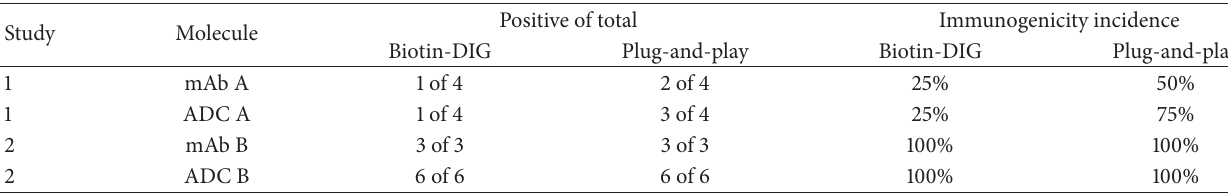
Table 5: Summary of immunogenicity data for cynomolgus monkey Studies 1 and 2 with the biotin-DIG ELISA and the plug-and-play assay. Samples from cynomolgus monkey studies with two ADCs and their corresponding mAbs were analyzed in the plug-and-play assay. The number of animals that developed anti-drug antibodies after exposure to the above molecules and the immunogenicity incidence obtained with this assay were compared to those previously obtained in the biotherapeutic-specific biotin-DIG ELISA. In Study 1, the plug-and-play assay detected the same positive responses as the biotin-DIG ELISA plus three additional animals with ADA positive responses. In Study 2, all the monkeys had positive responses with the biotin-DIG ELISA and the plug-and-play assay. Positive of total Immunogenicity incidence Study Molecule Biotin-DIG Plug-and-play Biotin-DIG Plug-and-play